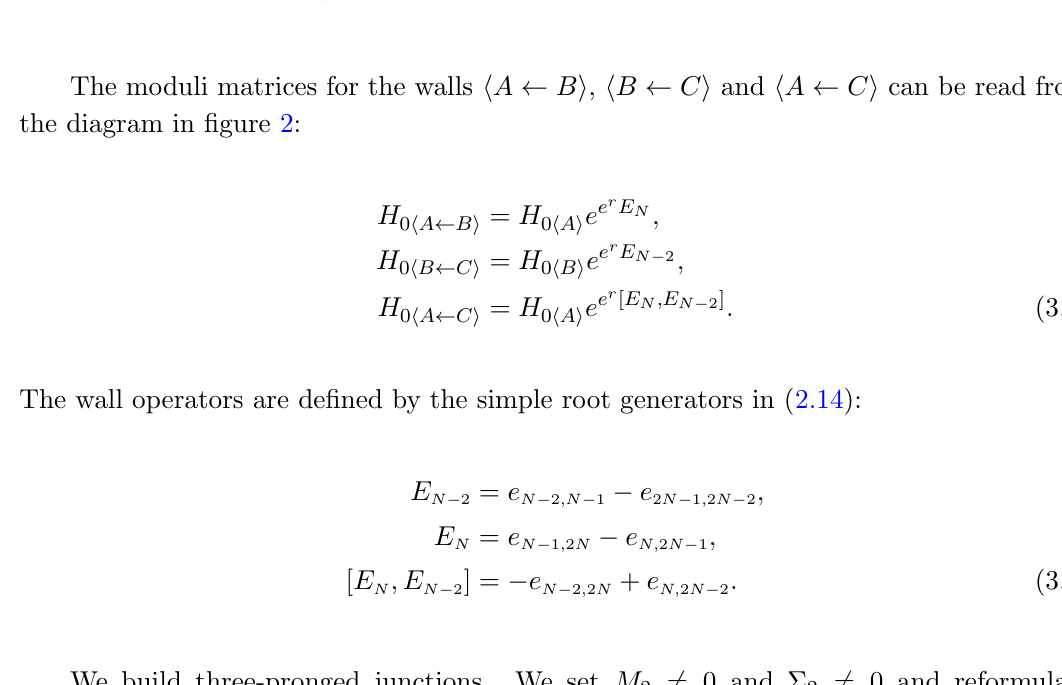
Figure 3 . SO(2 N ) = U( N ), N = 4 m . Vertices, line segments and triangular faces correspond to vacua, walls and three-pronged